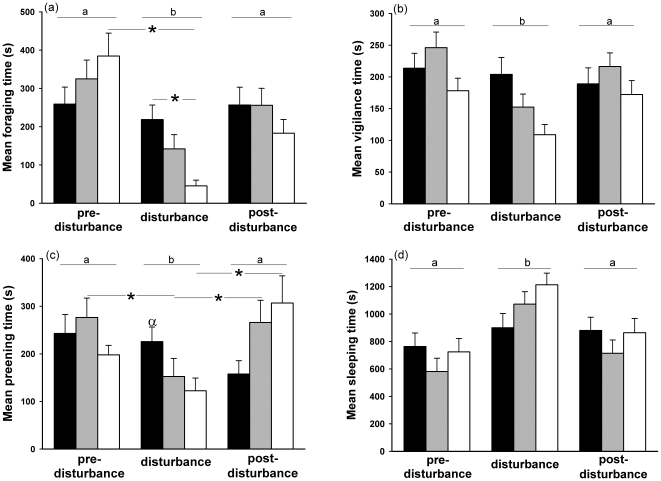
Time budget in teals.(a) Foraging, (b) vigilance, (c) preening and (d) sleeping behaviours for the week before the disturbance, the week of disturbance and the week after the disturbance for the control group (black bar), group 1 (grey bar) and group 2 (white bar) for each observation week. Letters indicate significant differences between weeks. *Indicates significant differences between weeks for a group or between two groups. α indicates that behaviour duration was significantly different for the control group compared to the two disturbed groups during the week of disturbance.